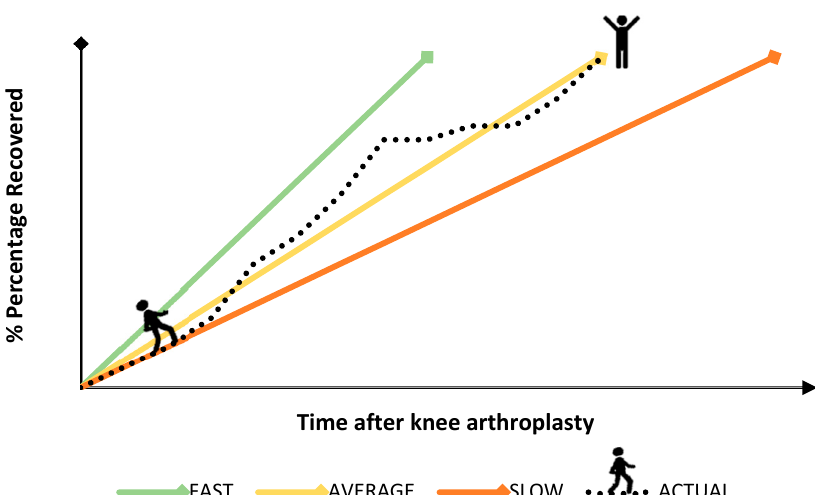
Figure 1. Hypothetical and schematic representation of three potential trajectories of recovery (i.e., fast, moderate and slow) for return to daily activities after knee arthroplasty. An example of a realistic and actual recovery trajectory of a patient, showing ups and downs during the recovery process, is also shown.